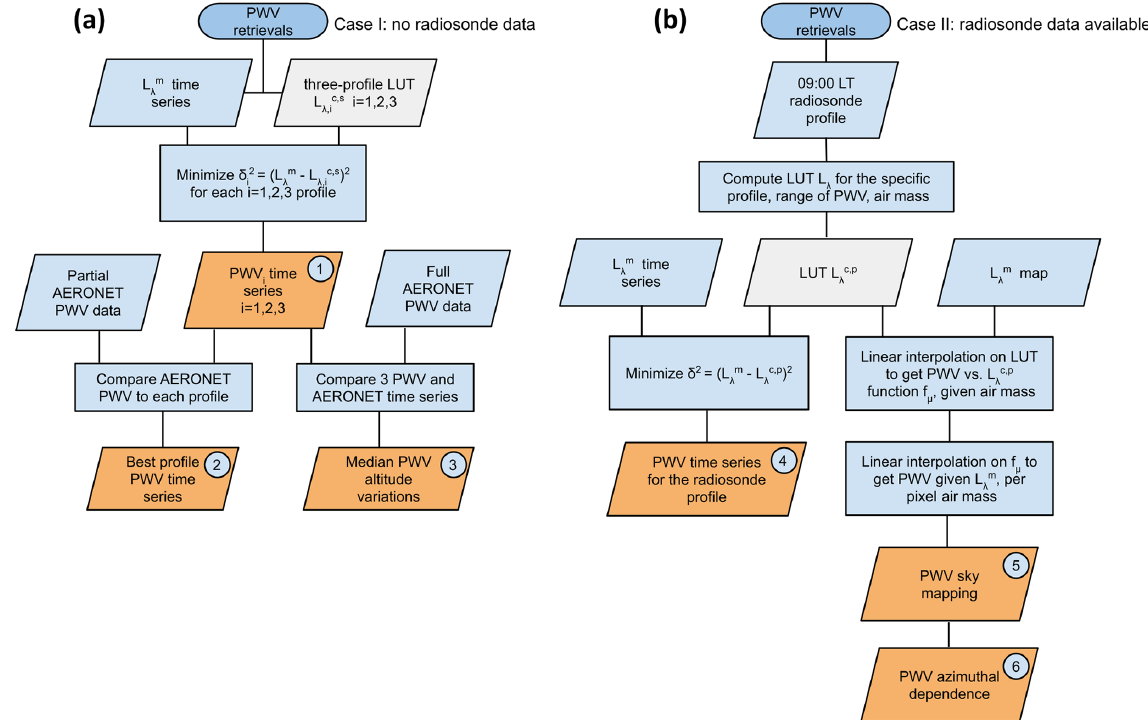
Figure 3. Method flow diagrams depending on the availability of radiosonde data: ( a ) ASIVA PWV retrievals without radiosonde data and ( b ) with additional radiosonde information at 09:00LT